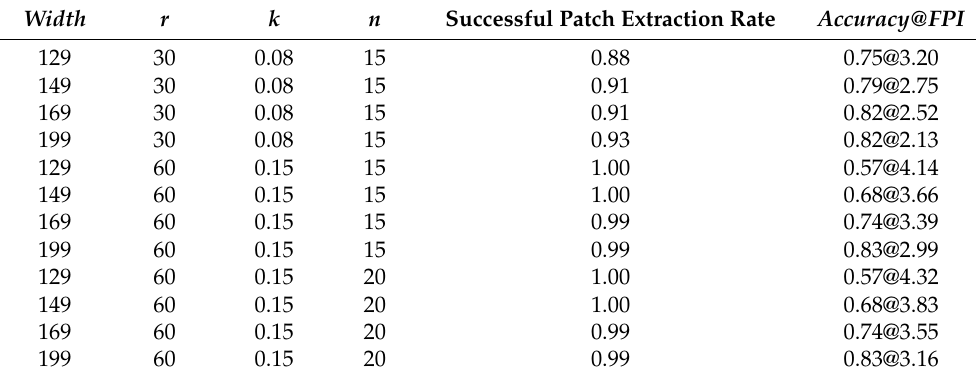
Table 7. Performance of patch extraction and mass detection on CBIS-DDSM with